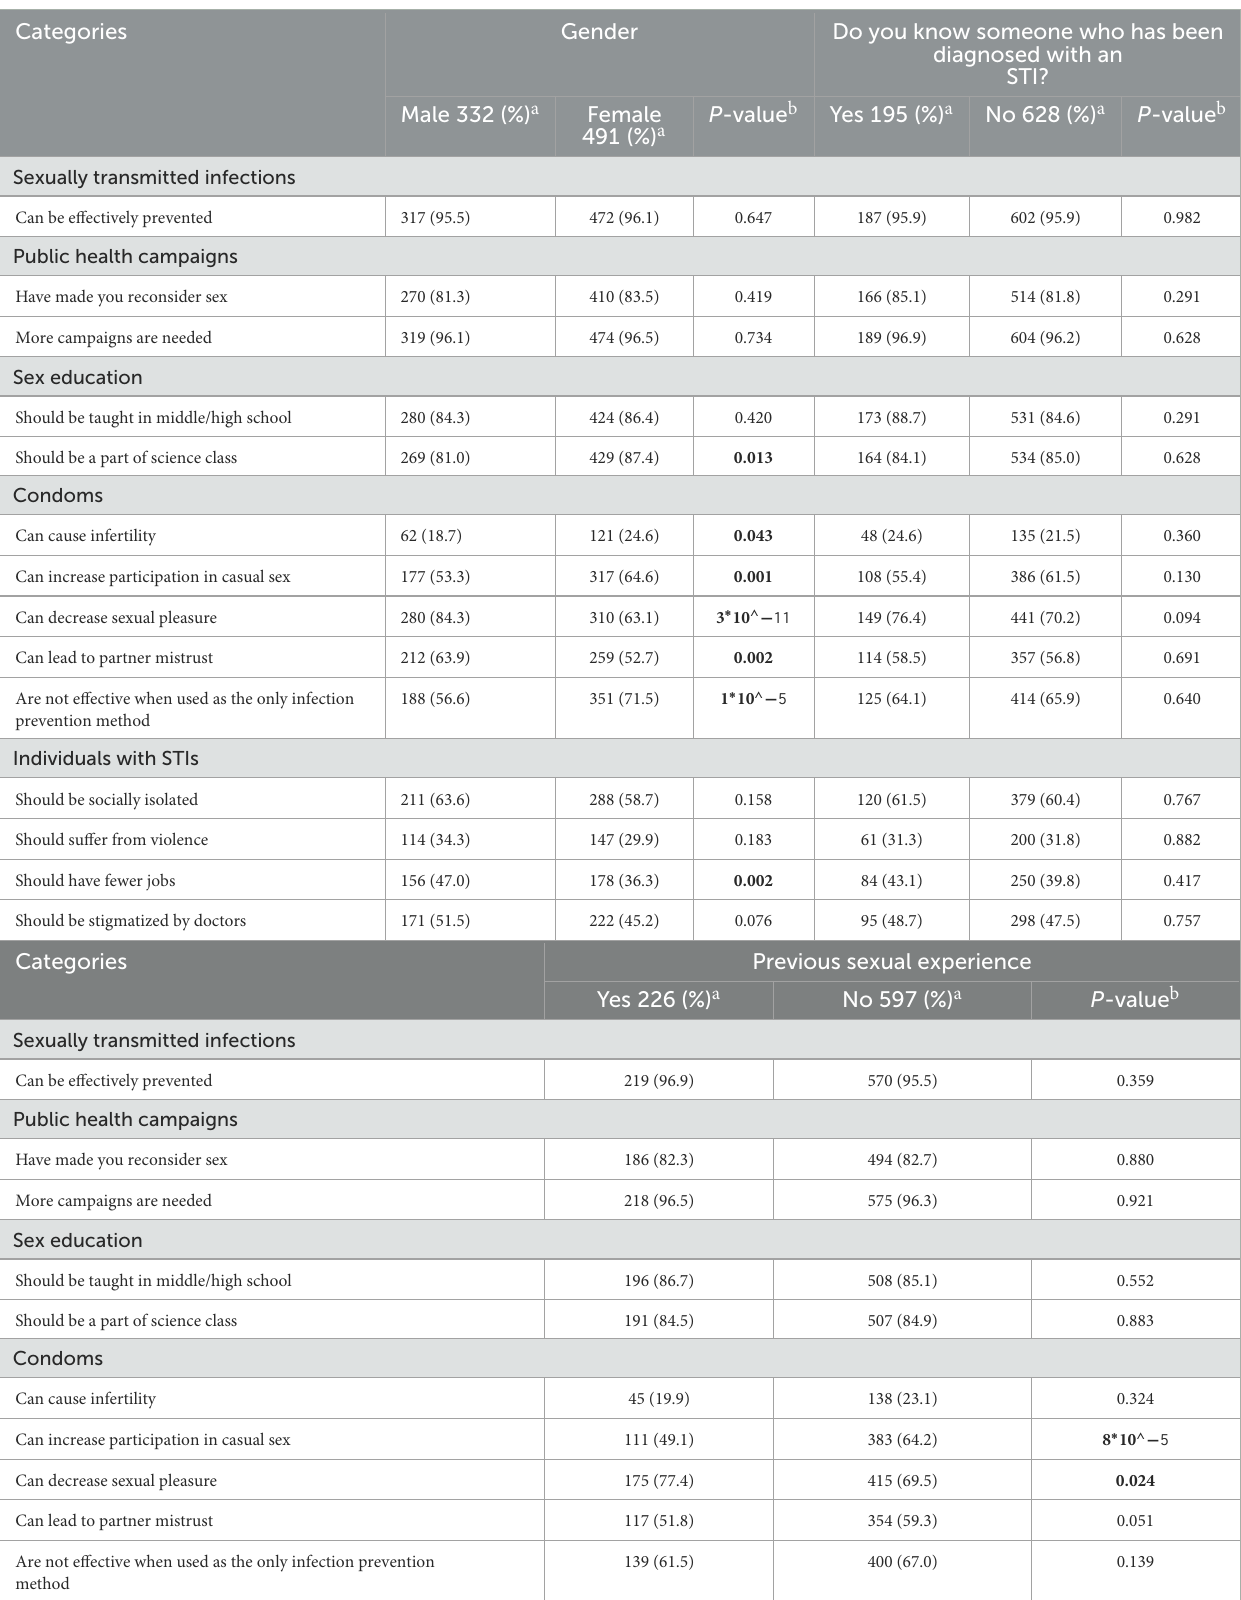
TABLE 3 Attitudes toward sexually transmitted infections, their prevention, and infected individuals among non-medical undergraduates in Baghdad,